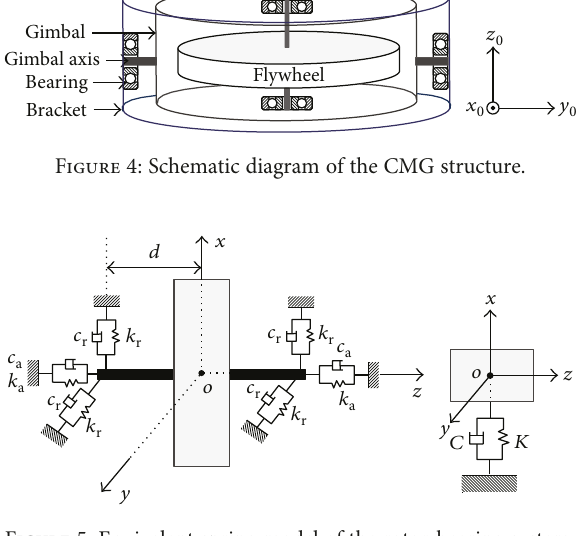
Figure 5: Equivalent spring model of the rotor-bearing system.